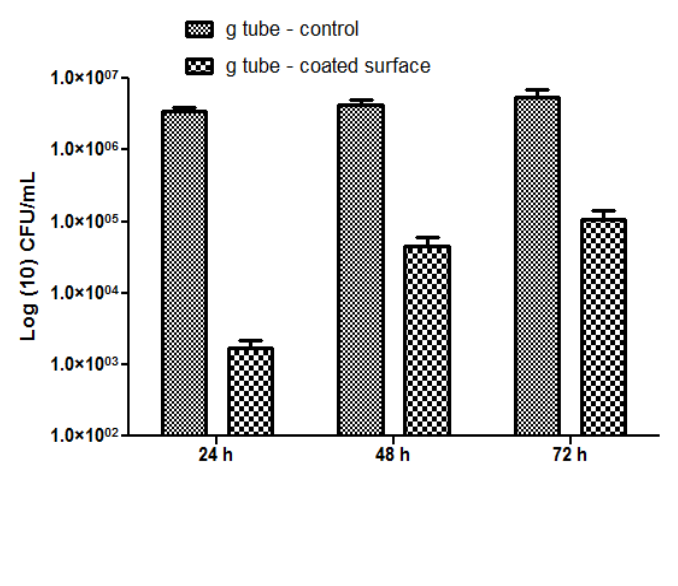
Figure 11. E. coli biofilms formation on ordinary (bare) and bioactive nanoparticle modified G-tubes for 24, 48 and 72 h of incubation at 37